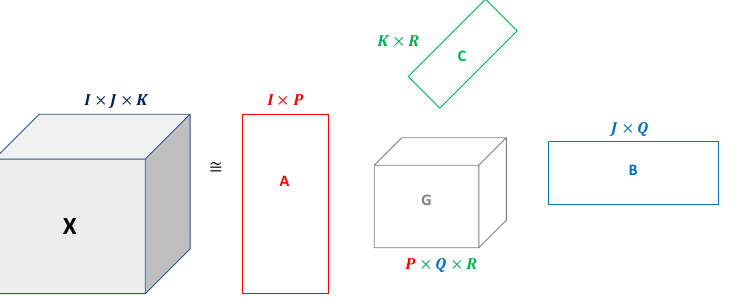
Figure 1. Tucker3 decomposition scheme. A tensor X is decomposed as factor matrices A , B , and C , one for each mode, and a core tensor G